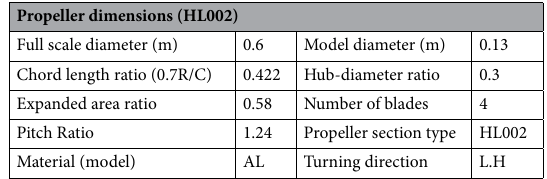
Table 3. Specifications of HL002 SPP.